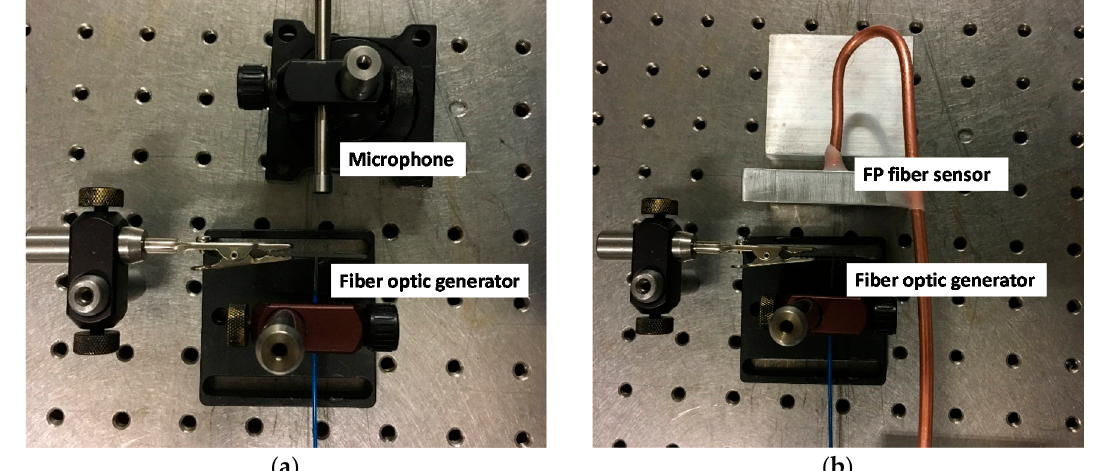
Figure 4. Experimental setup for the fiber optic ultrasonic sensing system verification. ( a ) The fiber optic generator and microphone system. ( b ) The fiber optic generator and FP sensor system.